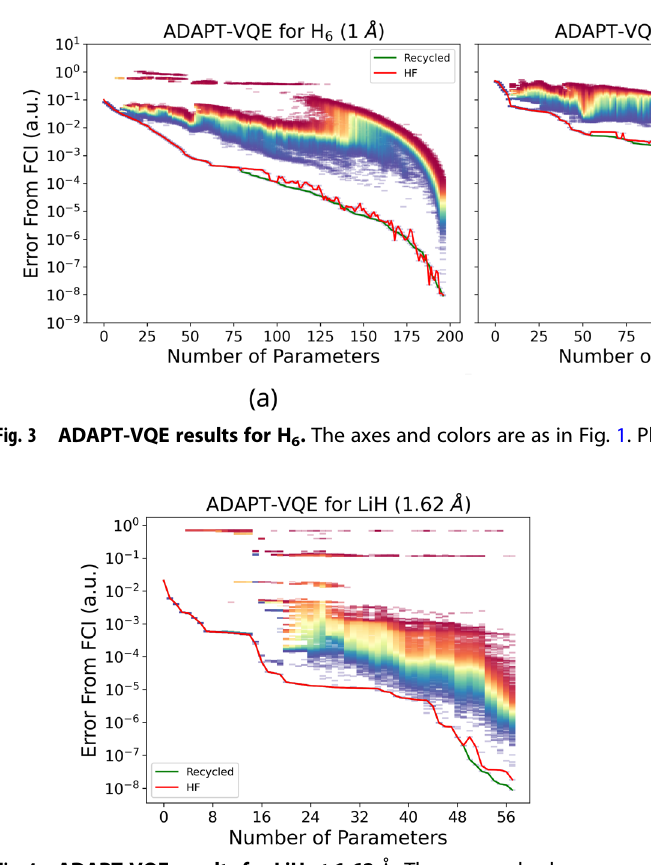
Fig. 4 ADAPT-VQE results for LiH at 1.62 Å . The axes and colors are as in Fig. 1.